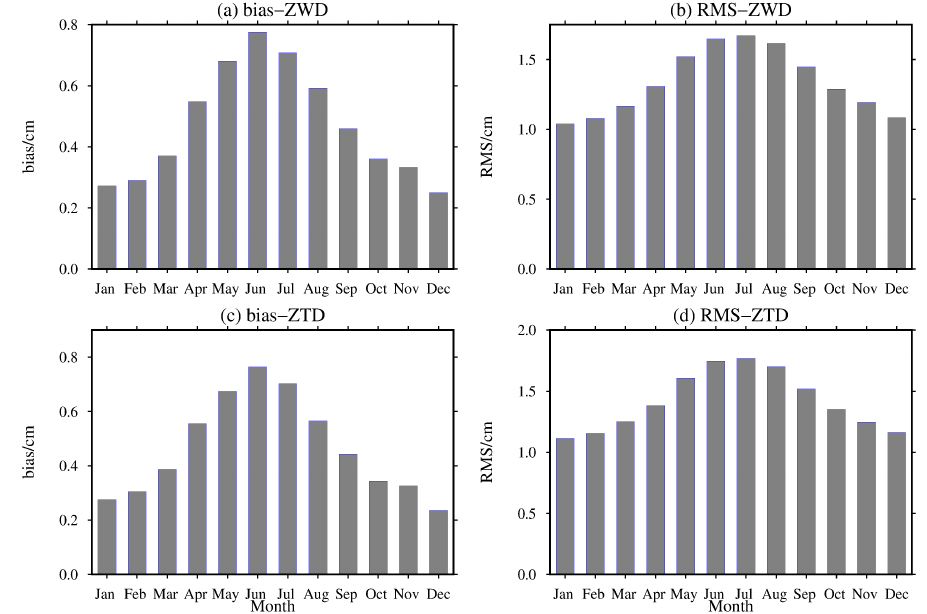
Figure 14. Monthly average distributions of the ( a , c ) bias and ( b , d ) RMS of the ZWD and ZTD values from the MERRA-2 data at the 409 radiosonde stations worldwide in 2015.